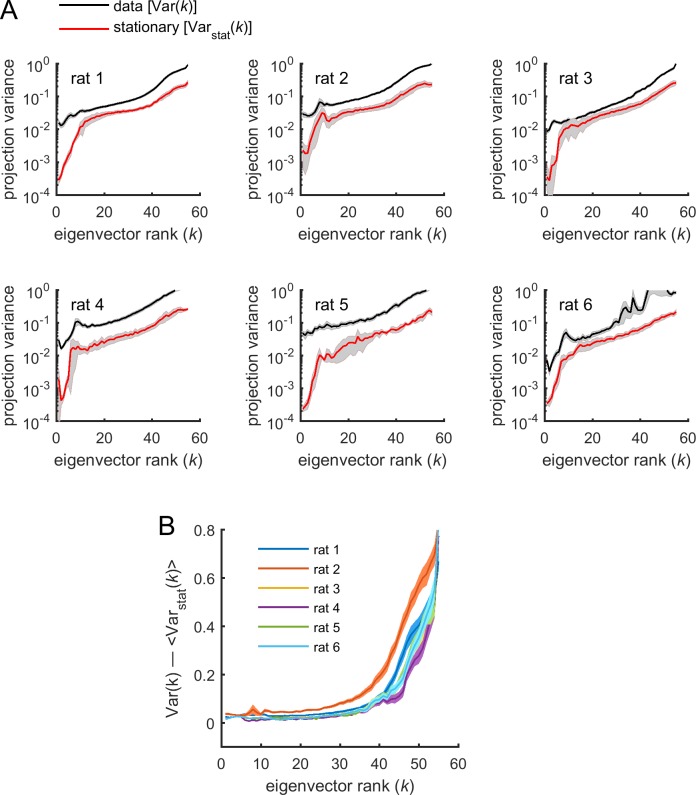
Parameters projections into FIM eigenvectors: data vs. stationary surrogates.The variance of projections of Ω(t′) into the different eigenvectors of the Fisher information matrix (FIM) for spiking data was compared to the one obtained from stationary surrogates. (A) The average variance of projections of model parameters into the different eigenvectors of the FIMs was calculated for the spiking data (parameters Ω(t')) and for the stationary surrogates (parameters Ω′(t′)), as a function of the rank k of the eigenvectors. Variances were noted Var(k) and Varstat(k) for the spiking data and the stationary surrogates, respectively. Traces represent average over neuronal ensembles and shaded areas represent SEM. Note logarithmic scale on the y-axis. We found that parameter fluctuations were larger than expected by estimation errors in the stationary case for all eigenvectors (i.e., Var(k)>Varstat(k), for all k). (B) The difference between variances of parameter projections estimated from the spiking data and those estimated from stationary surrogates increased with k. Thus, parameter fluctuations along sloppy dimensions were those that deviated the most from the stationary case. Traces represent average over neuronal ensembles and shaded areas represent SEM.